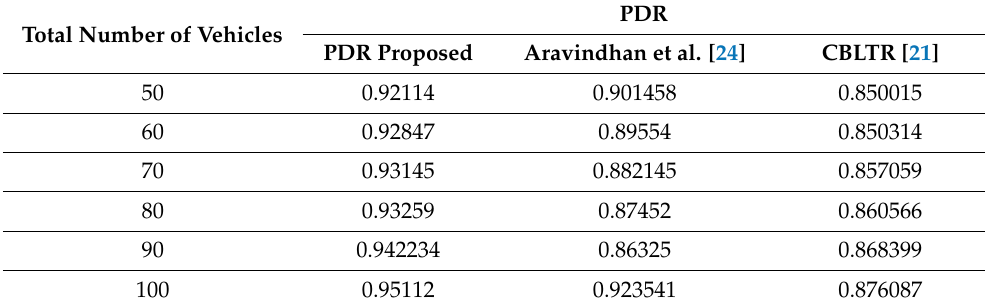
Table 6. PDR versus vehicular nodes in Area (1500 × 1500).